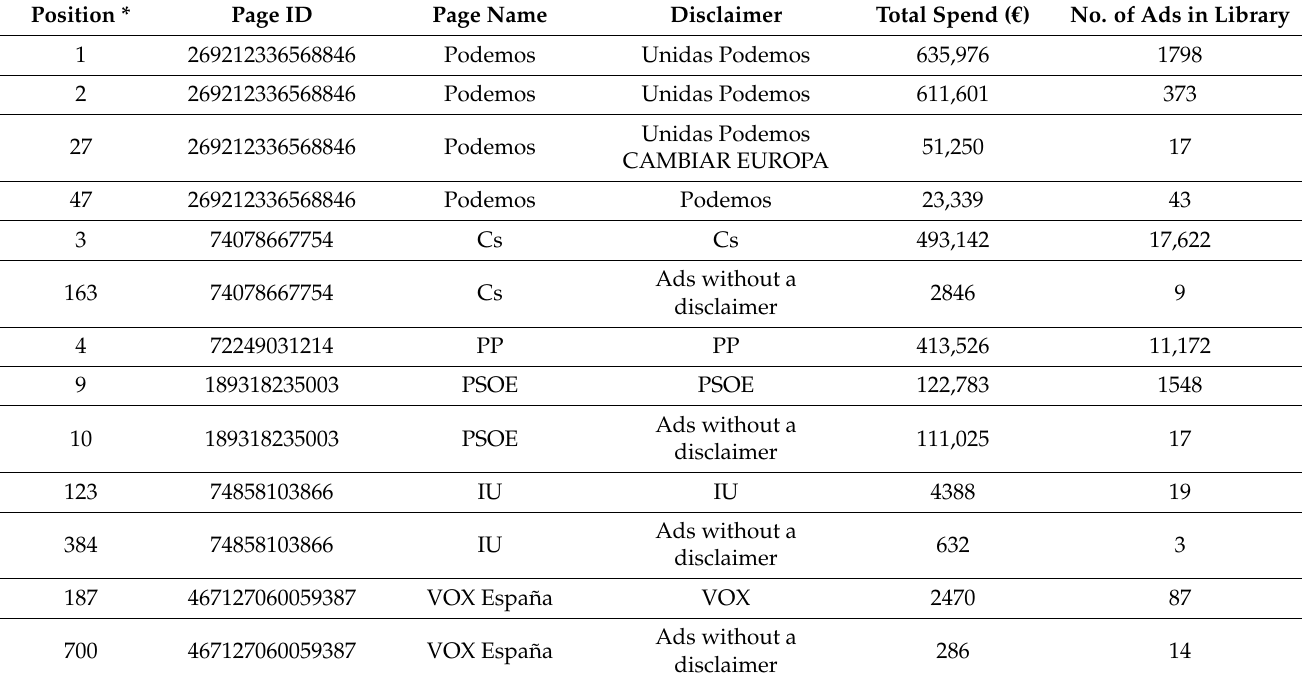
Table 2. Spanish political parties’ ad spend on Facebook from January 2019 to January 2020. Source: Facebook Ad Library report (January 2019–January